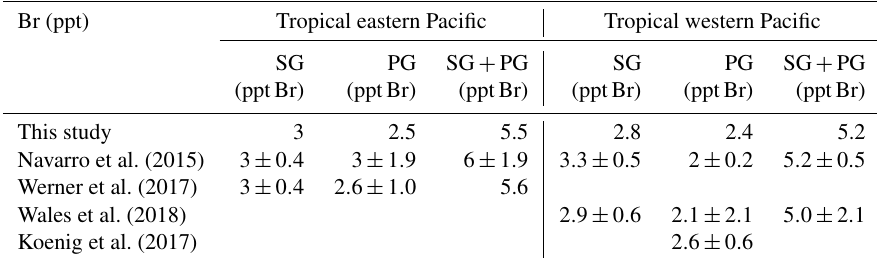
Table 3. Comparison of VSLS source gas (SG) contribution derived from this study and from aircraft measurements as well as product gas (PG) contribution derived from this study and studies linking aircraft measurements and